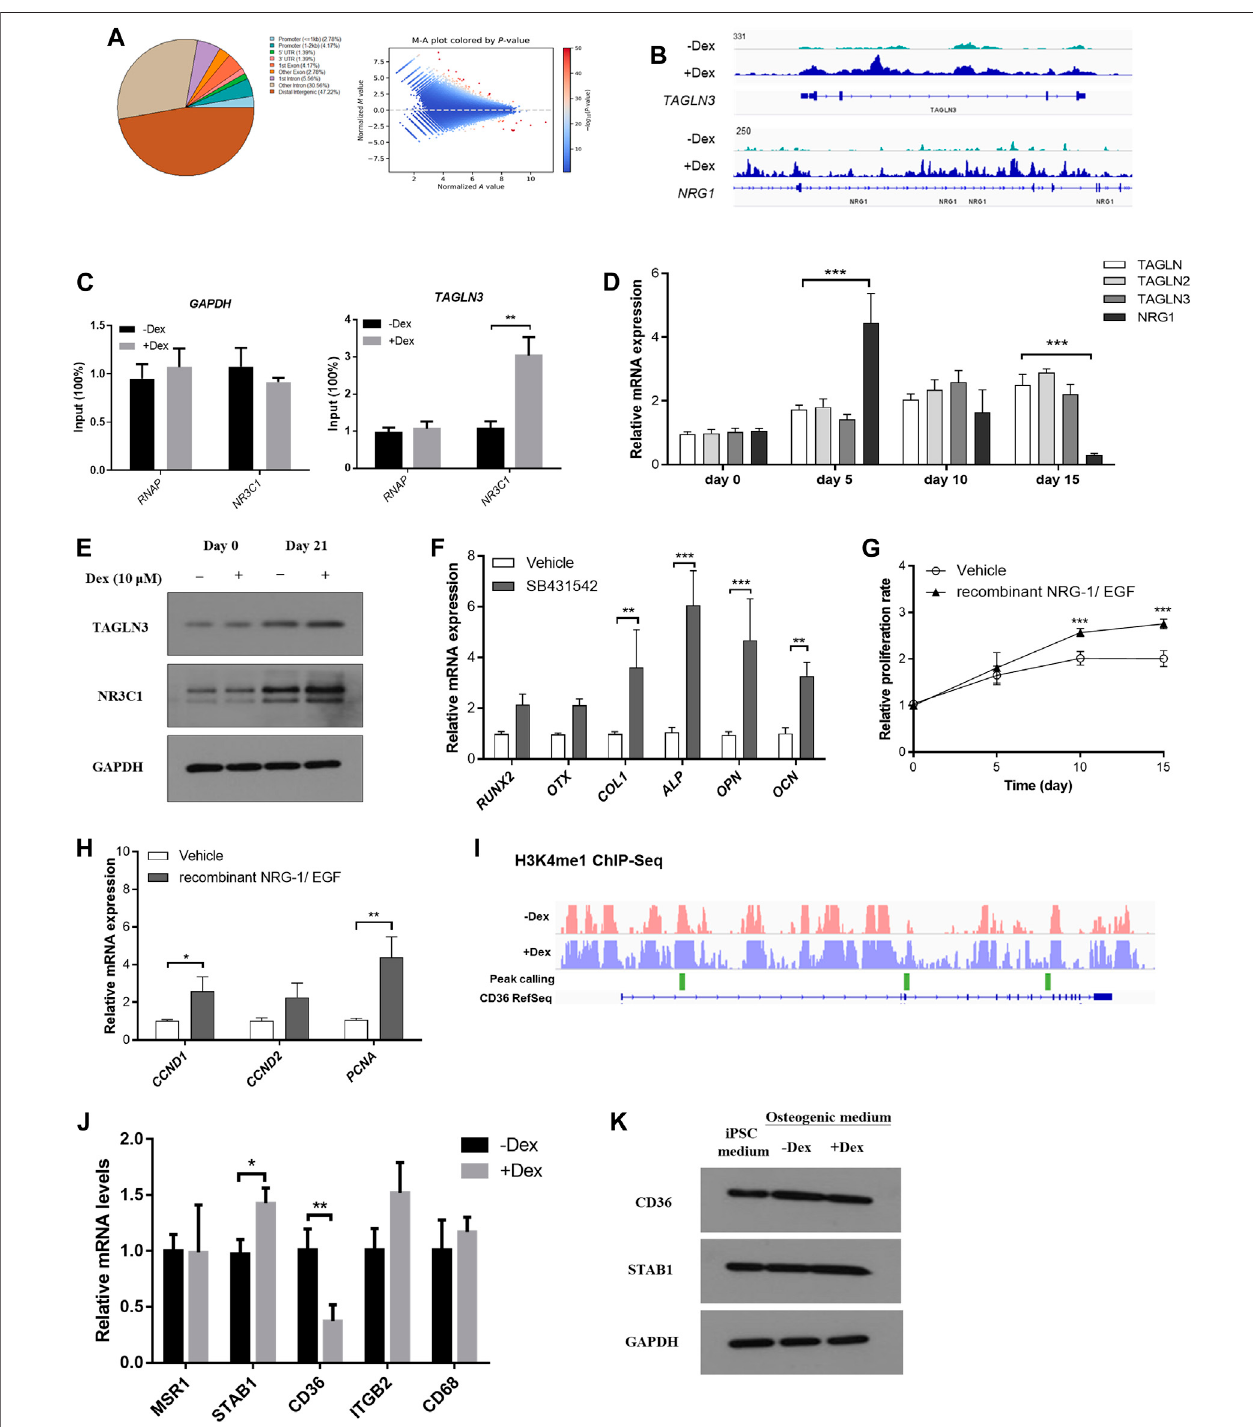
FIGURE 6 | Chromatin remodelling led to heightened enhancer accessibility to GC signaling in pre-conditioned MSCs. (A) Distribution of identi fi ed peaks MSC- derived osteoblasts with or without Dex treatment. (B) TAGLN3 and NRG1 showed differential peaks between vehicle-treated and those pre-conditioned with Dex. (C) CHIP-PCR of TAGLN3 and NR3C1 in MSC-derived osteoblasts. (D) The gene expression of TAGLN members and NRG1 along osteogenic differentiation. (E) The protein expression ofTAGLN3and NR3C1 alongosteogenic differentiation. (F) Osteogenic transcription factors geneexpression in pre-conditioned MSCs withor without co-treatment with SB431542 (TGF-beta inhibitor). (G,H) The proliferation and gene expression of the co-culturing of pre-conditioned MSCs with either recombinantNRG-1/EGF(NRG-1agonists). (I) RepresentativedifferentialpeaksofCD36betweenvehicle-treatedandthosepre-conditionedwithDex. (J,K) mRNAand protein expression levels of CD36 and its associated genes. * p < 0.05, * p < 0.01, signi fi cantly different from Ctrl.